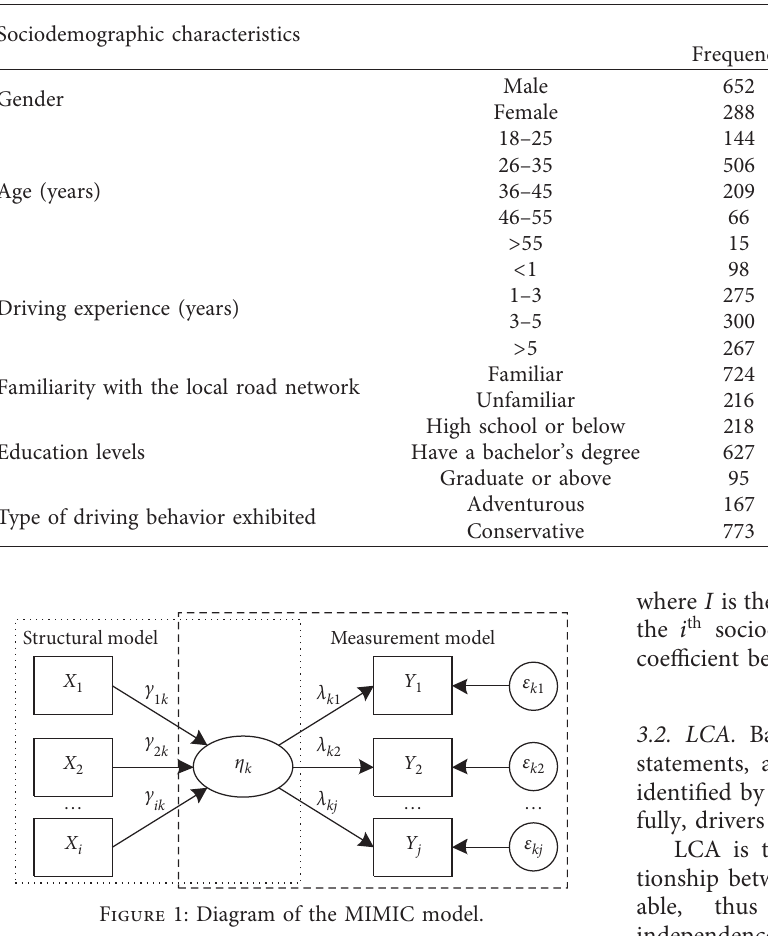
Table 2: Descriptions of the sample (2015 and 2019